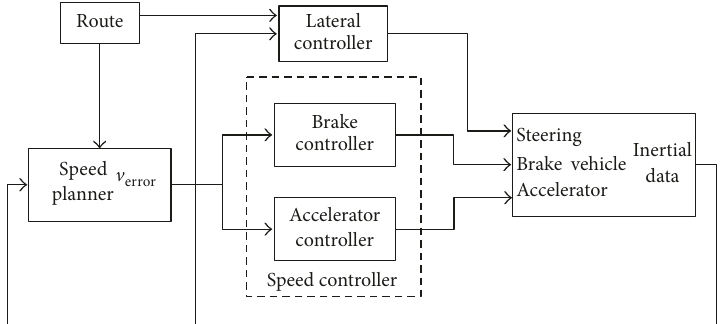
Figure 6: Decision and control block of general automated driving framework.